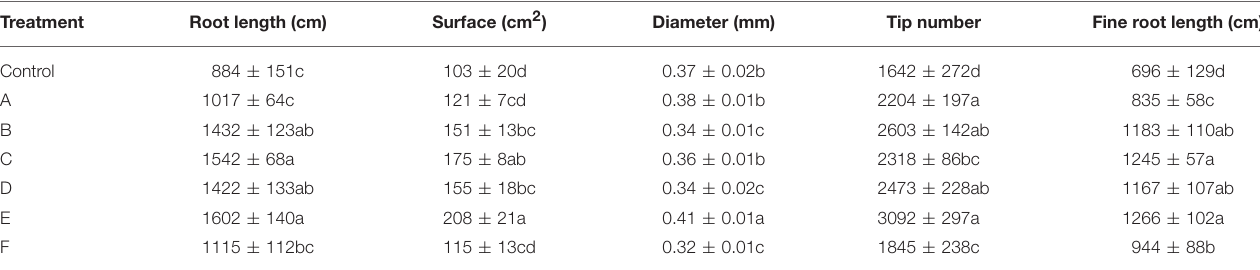
TABLE 4 | Root growth-associated parameters of control maize plants (untreated) and plants supplied for 48h with extracts obtained from the seaweeds Laminaria (A) and Ascophyllum nodosum (B–F). Treatment